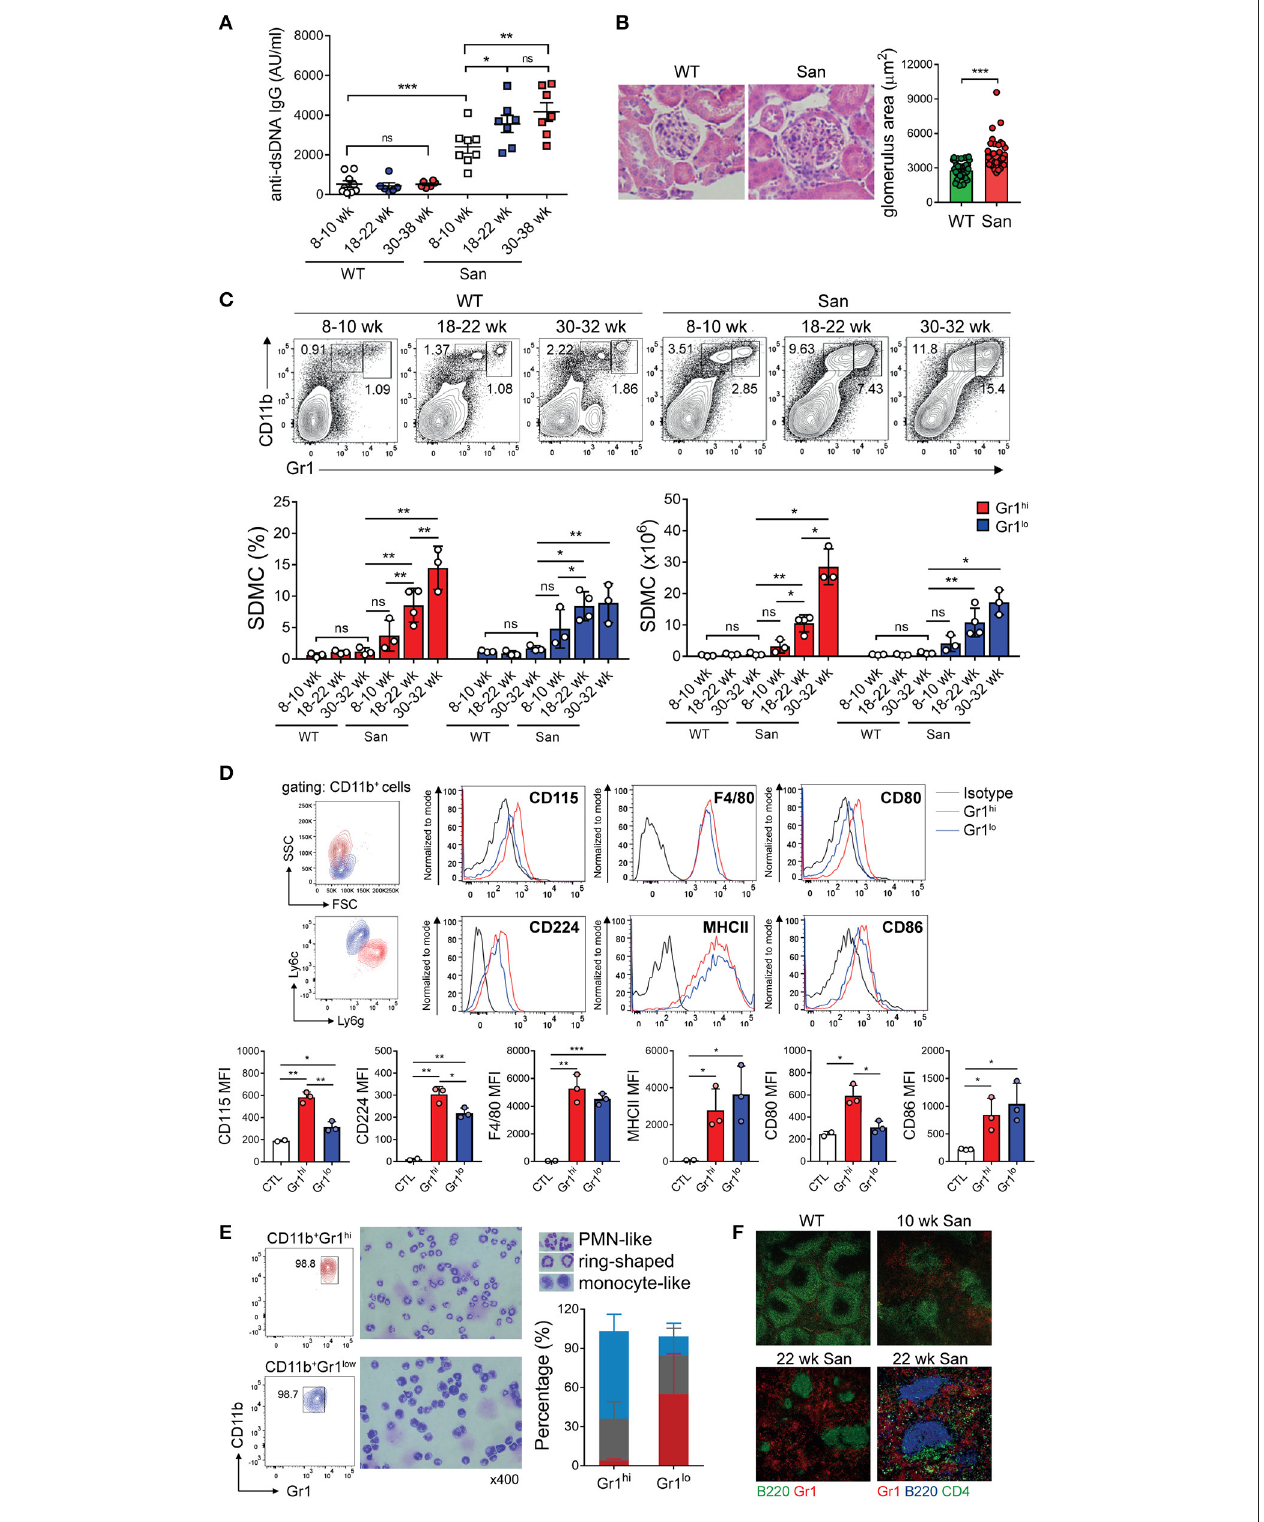
FIGURE 1 | Accumulation of myeloid cells in sanroque mice. (A) Sera from sanroque mice and WT littermates at the indicated ages were assayed by ELISA to measure anti-dsDNA IgG titers. (B) Kidney sections of 18–22 week-old mice were stained with H&E and assayed by histopathological methods. (C,D) Spleen cells from sanroque and WT mice were assayed by FACS. FACS profiles were gated on whole live cells (C) and CD11b + cells (D) , and percentages of cells within the